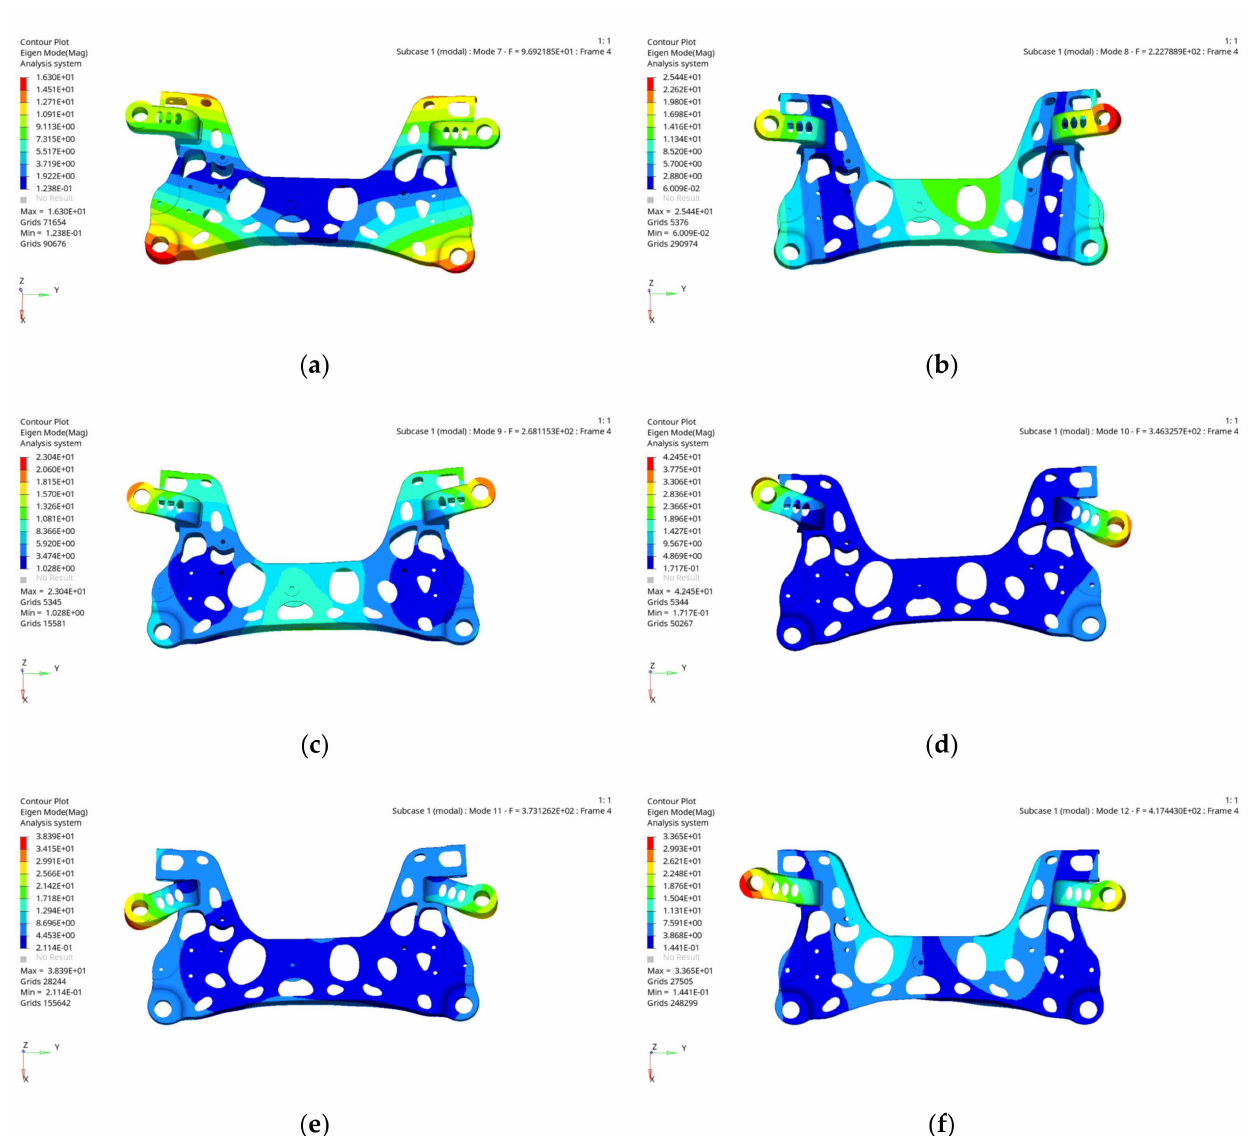
Figure 17. Optimized non-rigid body modal shapes for the front 6th order of the aluminium alloy front subframe. ( a ) First modal shape. ( b ) Second order modal shapes. ( c ) Third order modal shapes. ( d ) Fourth order modal shapes. ( e ) Fifth order modal shapes. ( f ) Sixth order modal